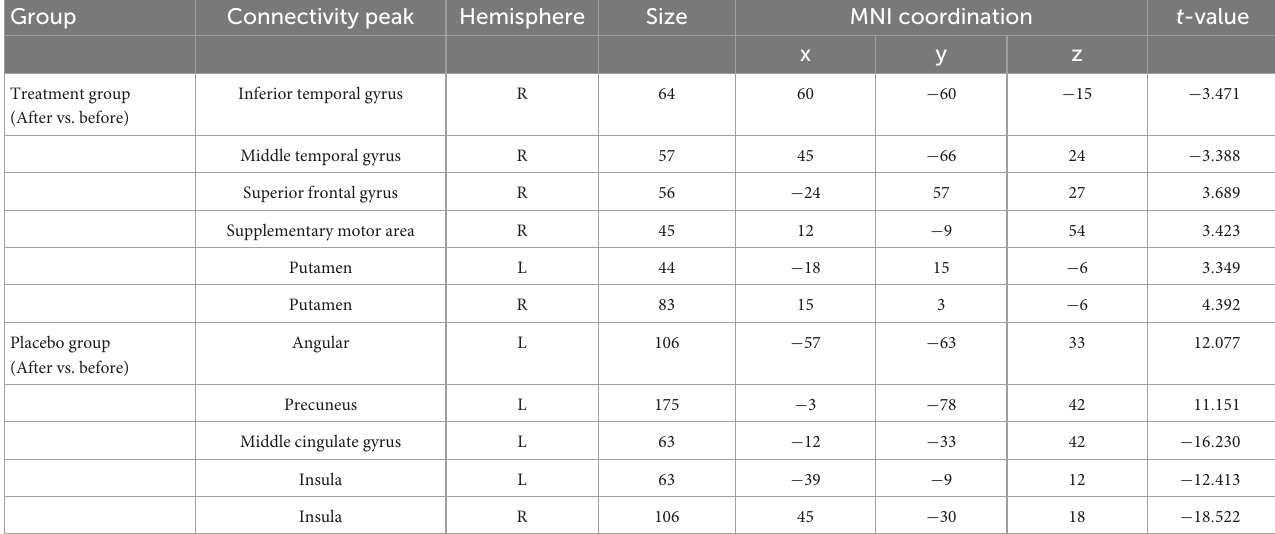
TABLE 2 Seed-based static functional connectivity group comparisons. Group Connectivity peak Hemisphere Size